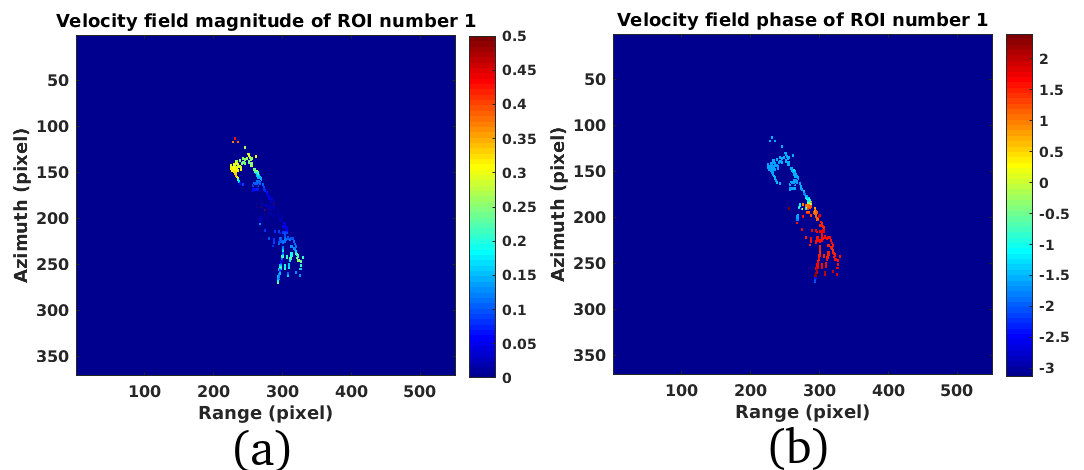
Figure 8. ( a ): Magnitude of the range-azimuth displacement. ( b ): Phase of the range-azimuth displacement.